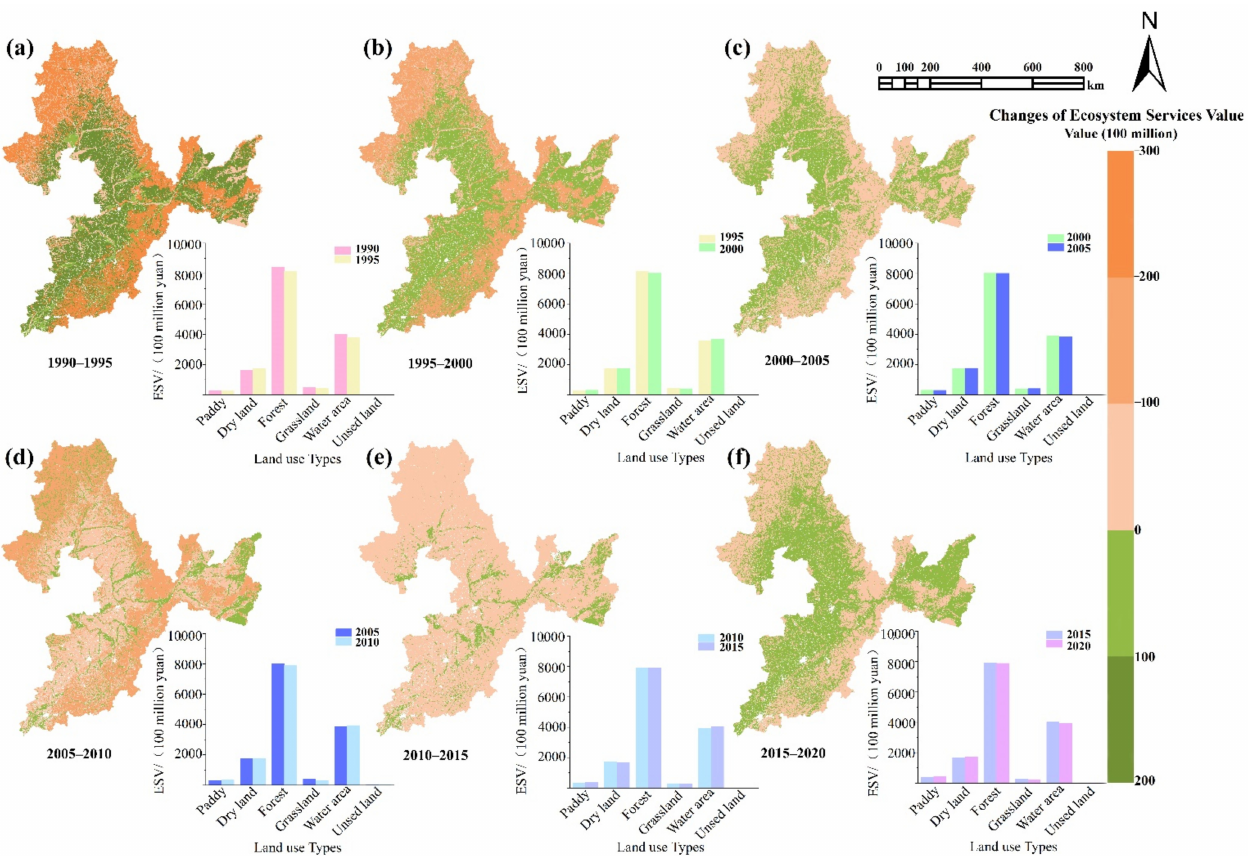
Figure 4. Spatial variation of the ESV in the BSRNC. Notes: The subfigures represent the change in ESV for different land use